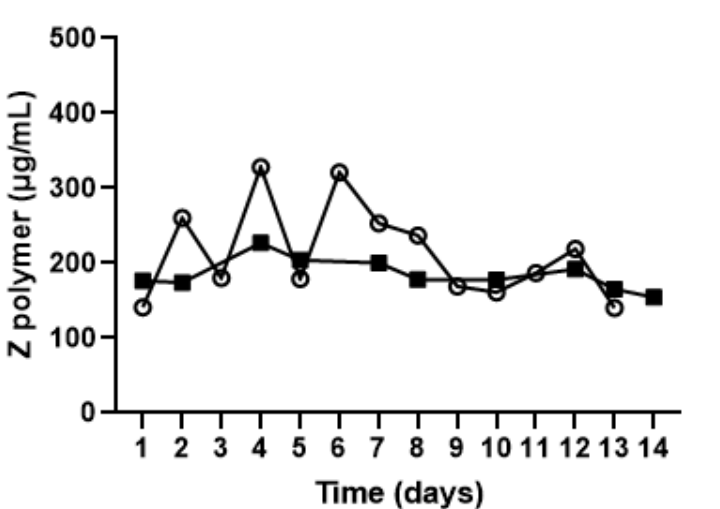
Figure 3. Repeatedly determined plasma levels of Z-AAT polymers in two randomly selected ZZ- AATD patients. On 14 consecutive days, plasma levels of Z-AAT polymers remained relatively stable in both patients.